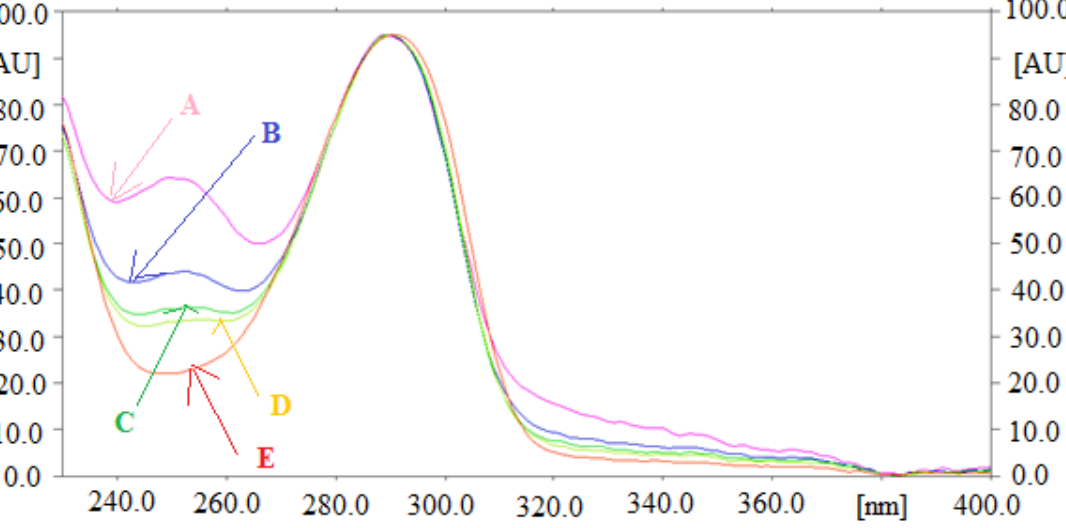
Figure 2. Overlaid ultraviolet (UV) absorption spectra of (A) standard HDQ, (B) commercial whitening cream (CWC) A, (C) CWC B, (D) CWC C, and (E) CWC D.